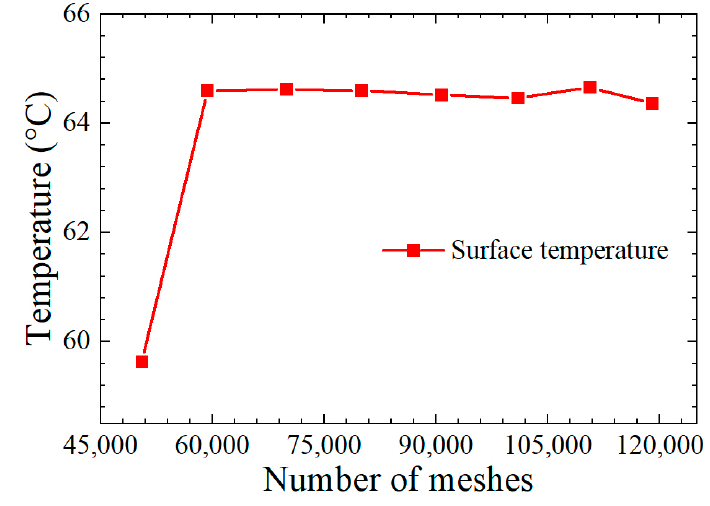
Figure 3. Verification of grid independence.